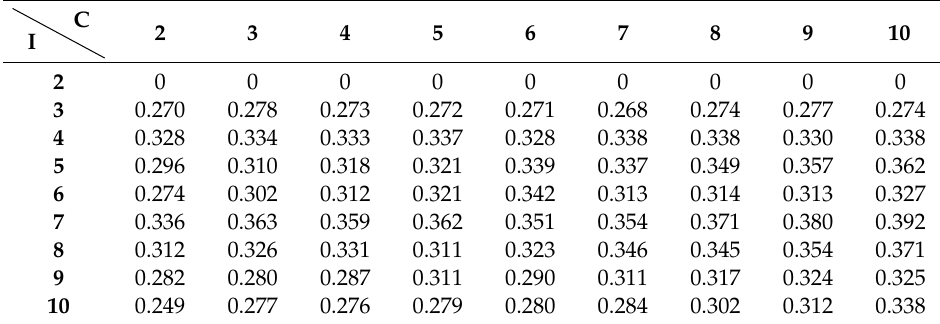
Table 1. Concrete compressive strength (CCS) prediction results for interval-based IGM (Case 1) using training data.